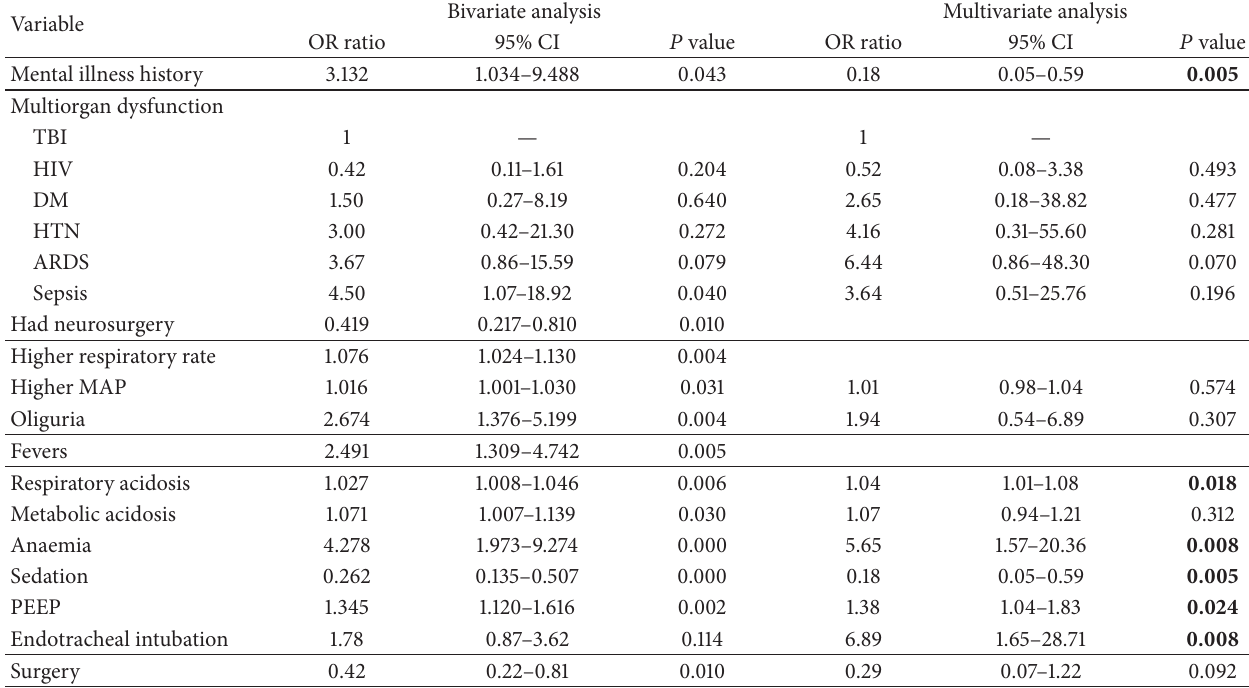
Table 5: Significant predictors for delirium among ICU patients on mechanical ventilation at bivariate and multivariate